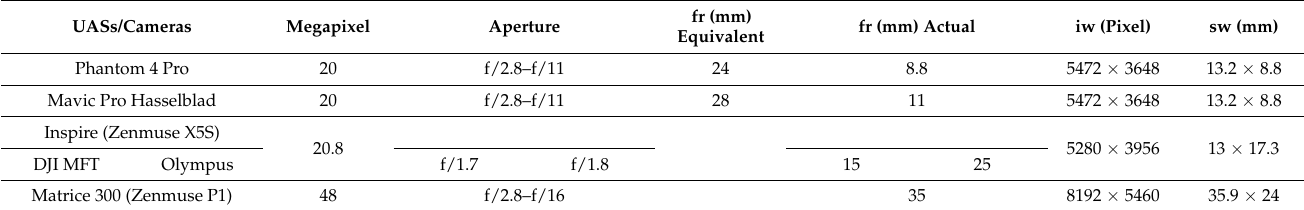
Table 1. Characteristics of UASs and cameras used in image